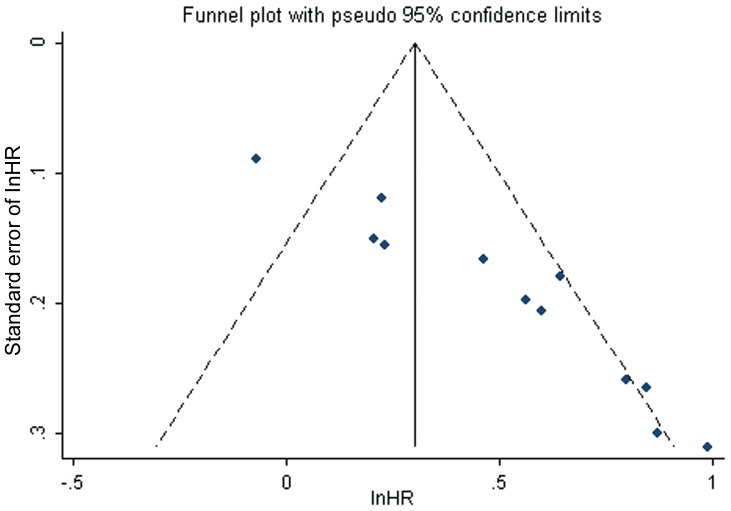
Funnel plots illustrated significant asymmetry on HR for overall survival of all patients.Studies were distributed asymmetrically and suggested biases exist.